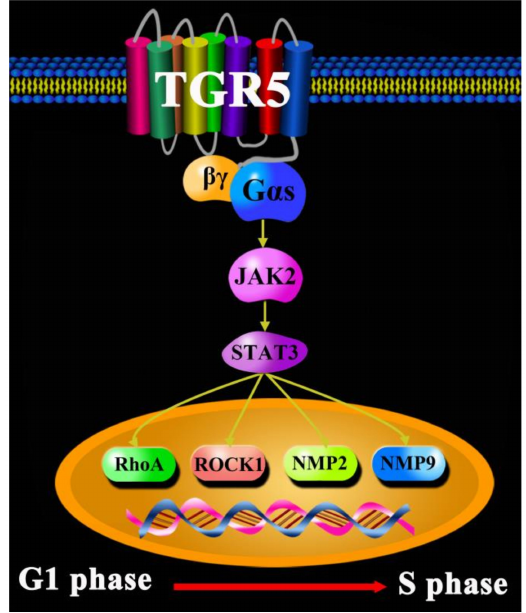
Figure 4. TGR5 in liver